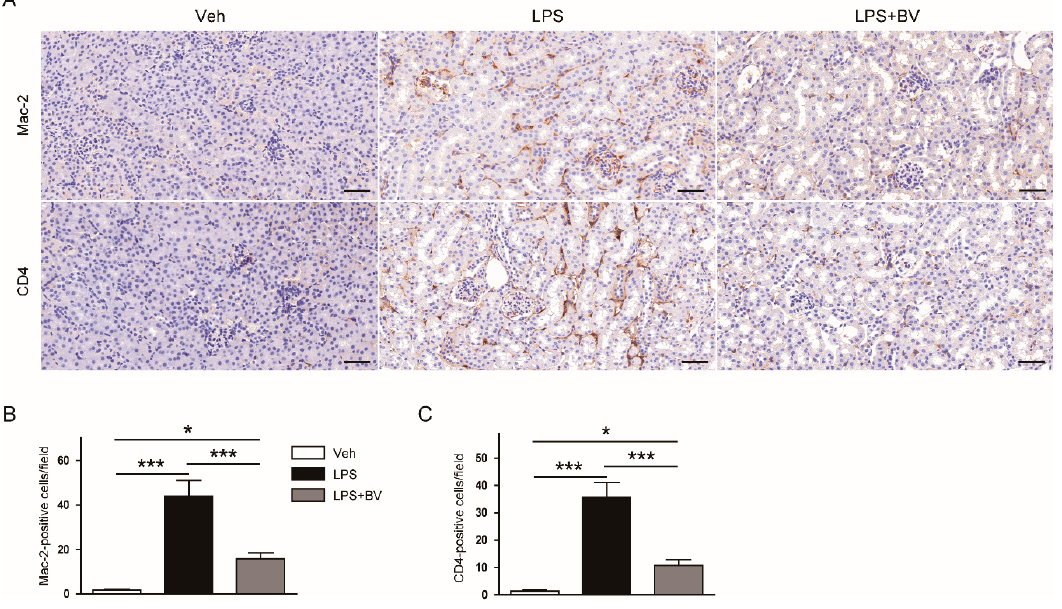
Figure 5. Bee venom prevented immune cell infiltration into damaged kidneys in LPS-treated mice. ( A ) IHC staining of kidney sections using antibodies against Mac-2 or CD4. Bar = 100 µ m. ( B ) Number of Mac-2-positive cells. ( C ) Number of CD4-positive cells. n = 8 per group. * p < 0.05 and *** p < 0.001.